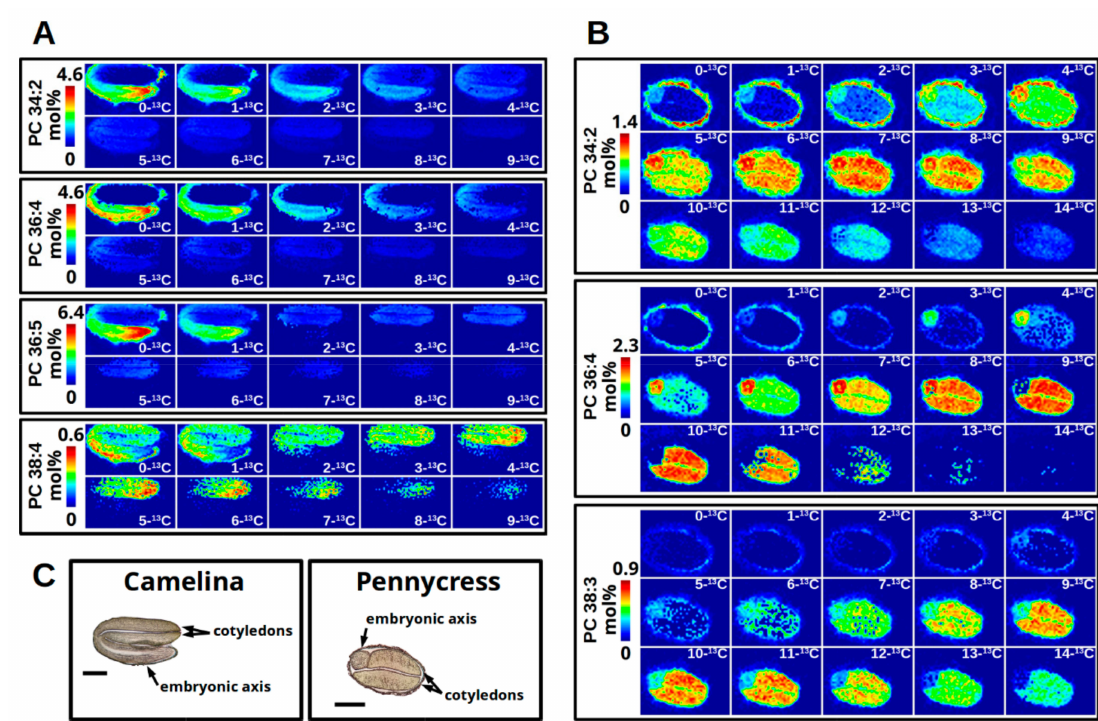
Figure 4. 13 C-MS imaging of PC from a developing Camelina embryo ( A ) and a developing pennycress embryo ( B ) isotopi- cally labeled with [U- 13 C]-glucose for 64 h and 120 h, respectively. Brightfield images ( C ) of Camelina and pennycress embryo sections indicate anatomy and localization of cotyledon and embryonic axis tissues (scale bar = 500 µ m). Isotopologues of 13 C-MS imaging are aligned from least to most 13 C incorporation from left to right and top to bottom. Each set of images for each molecular species is set to a colorimetric scale from dark blue (low abundance) to red (high abundance) representing mol% relative to the TIC of the imaging data. In Camelina ( A ), the greatest abundance for PC 34:2 (4.6), PC 36:4 (4.6), PC 36:5 (6.4) have low 13 C incorporation and are localized to the embryonic axis (bottom). Isotopologues of greater 13 C incorporation localize to the cotyledons (top) for PC 34:2 and PC 36:4, and exclusively for PC 36:5. PC 38:4 shows a low overall abundance for all isotopologues (0.6), but a more equal abundance between the isotopologues with greater 13 C incorporation occurring in the cotyledons. In Pennycress ( B ), the isotopologue mol% abundance between the embryonic axis (left) and the cotyledons (right, most of embryo) for PC 34:2 and PC 36:4 are nearly equal, except PC 34:2 shows a similar isotopic enrichment between the two tissues whereas PC 36:4 shows different levels of enrichment (i.e., less in embryonic axis, more in cotyledons). PC 38:3 localizes only to the cotyledons with greater abundance at higher isotopologue